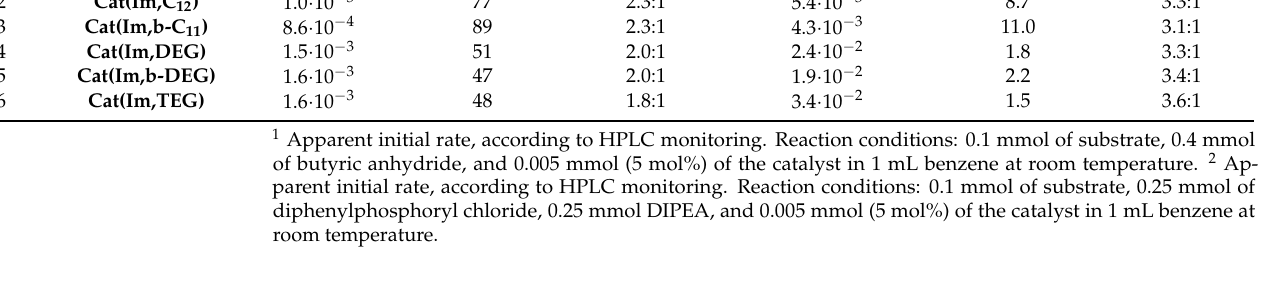
Table 4. Butyrylation and phosphorylation of substrate 1 , promoted by the catalysts of the BMAP family, as depicted in Scheme